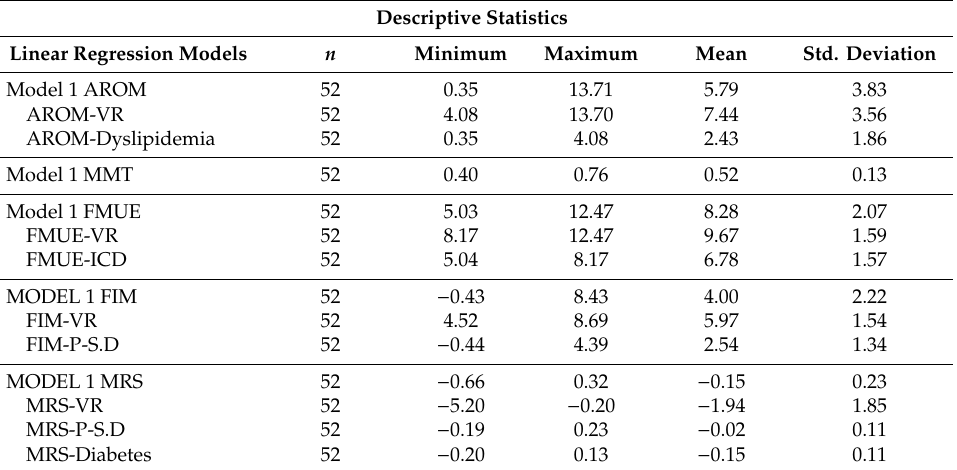
Table 6. Multiple linear regression prediction